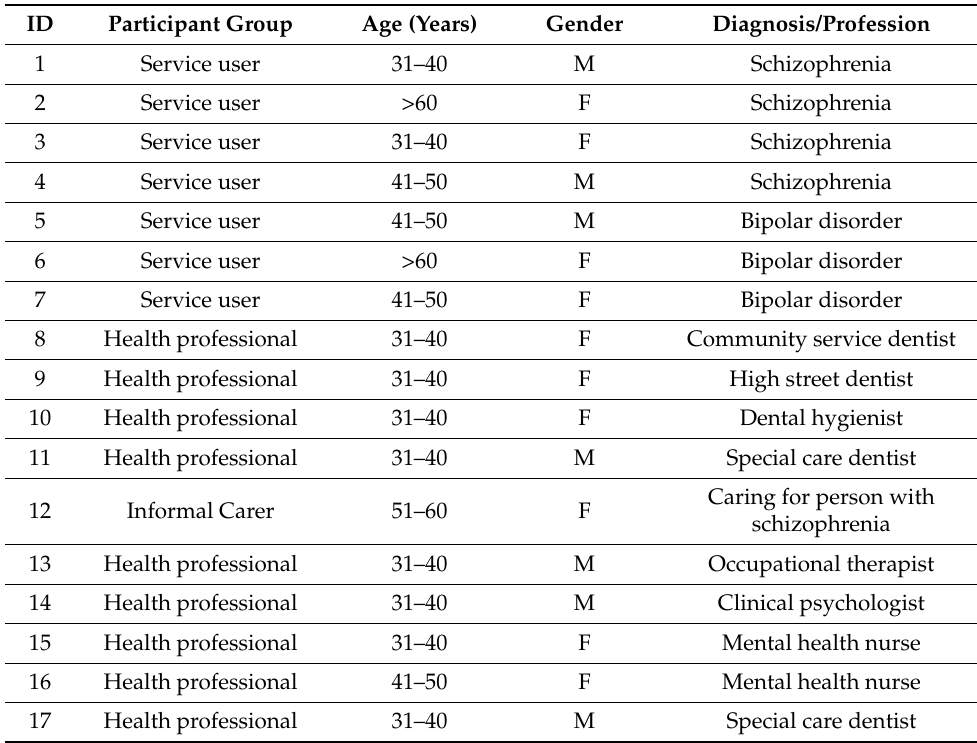
Table 1. Demographics of the study